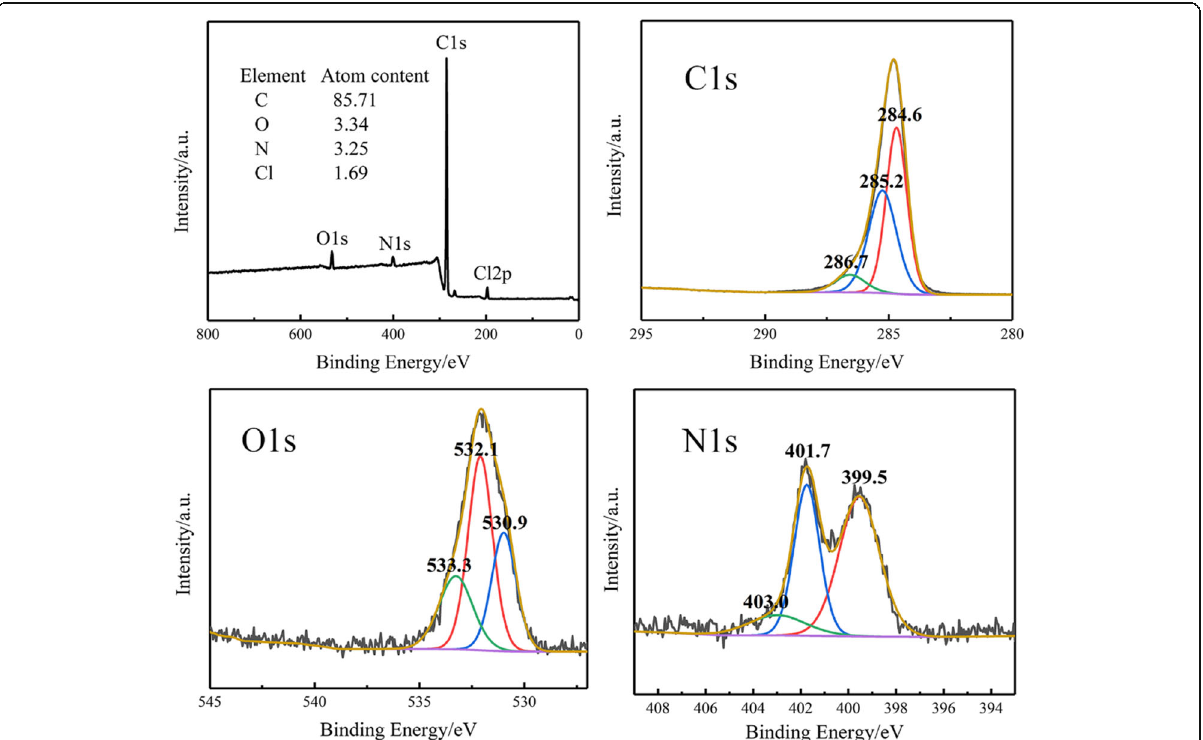
Fig. 2 X-ray photoelectron spectroscopy (XPS) spectra of CPC-CQDs ( a ) and C1s, O1s, and N1s of CPC-CQDs ( b , c , and d )